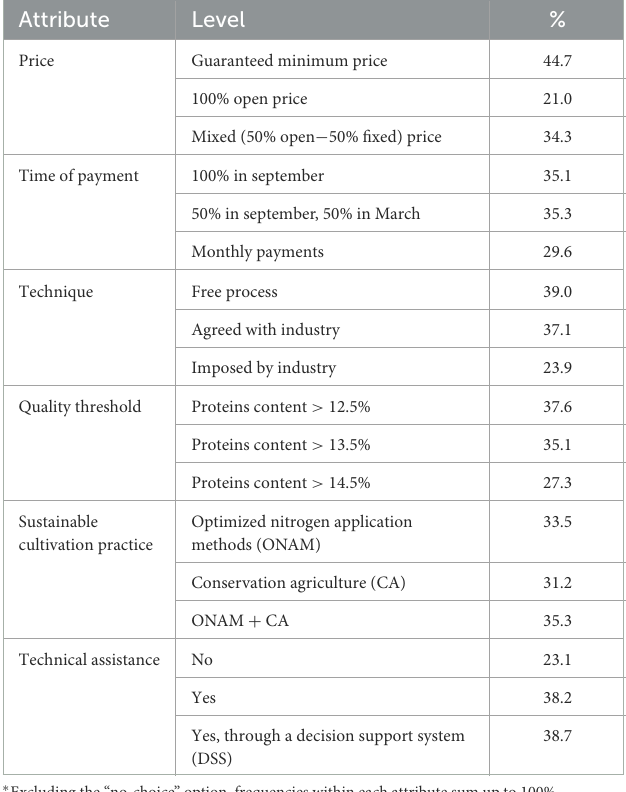
TABLE 3 Percentage of “yes” for each attribute ( n = 384 ∗